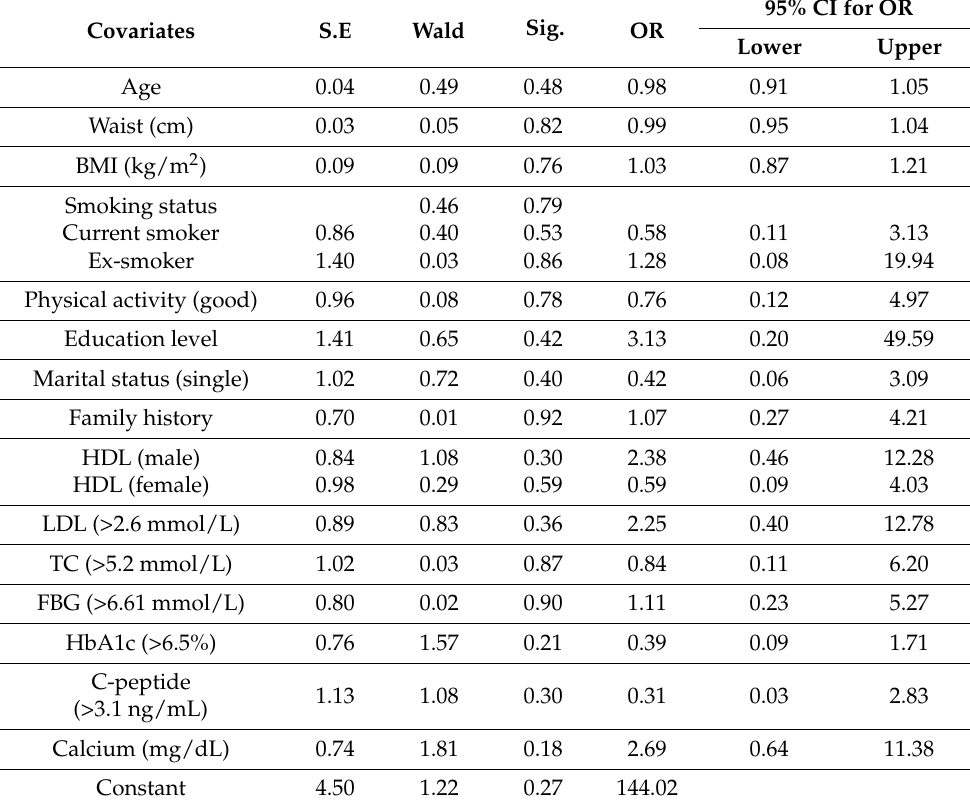
Table 6. Prediction of risk factors associated with vitamin D 3